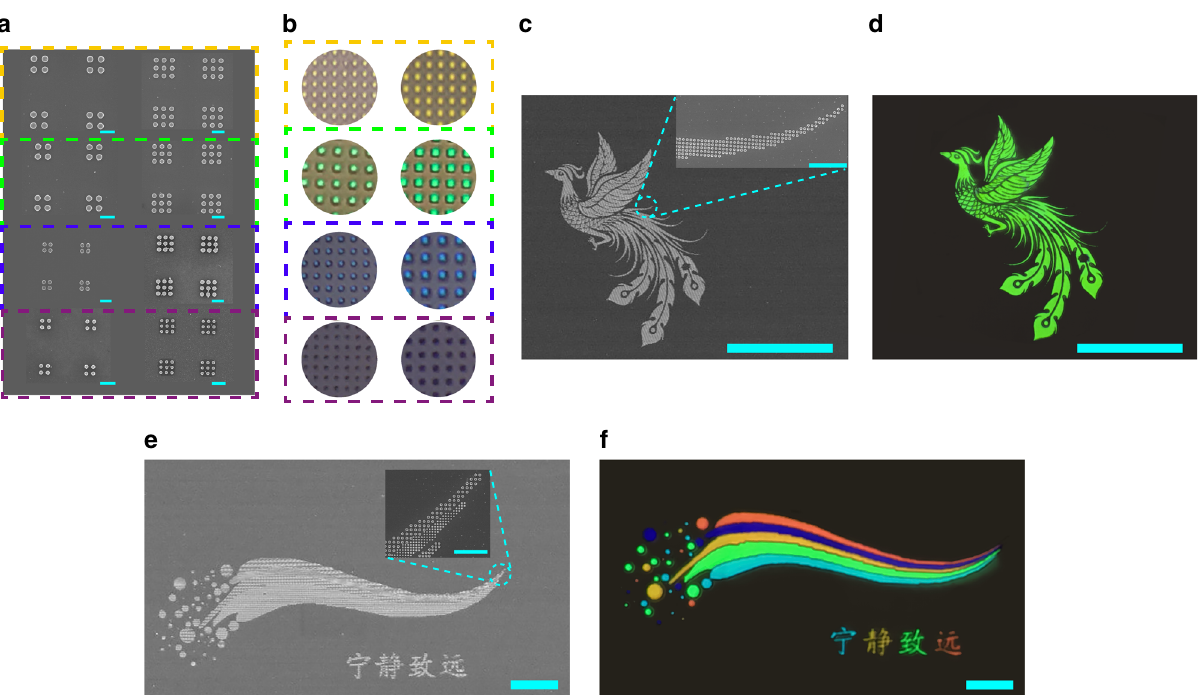
Fig. 4 The resolution test of the all-dielectric structural color. a The top-view SEM images of Si metasurfaces with different lattice and different pixel sizes. The scale bar is 400 nm. b The experimentally recorded bright- fi eld microscope images. The smallest pixel sizes for yellow, green, blue, and purple colors are 320, 250, 200, and 190 nm, respectively. c The top-view SEM images of “ Phoenix ” . d The pure color image of a “ Phoenix ” with different pitch sizes. No color degradation can be seen with the reduction of pixel size. The insets show the SEM images at different locations. e The top-view SEM images of “ rainbow ” . f The microscope image of a color “ Rainbow ” with different pixel sizes. Different colors can be well distinguished at the diffraction-limit resolutions. The scale bars are 100 µ m in ( c , d ), and 20 µ m in ( e , f ). The scale bars of insets in ( c , e ) are 250